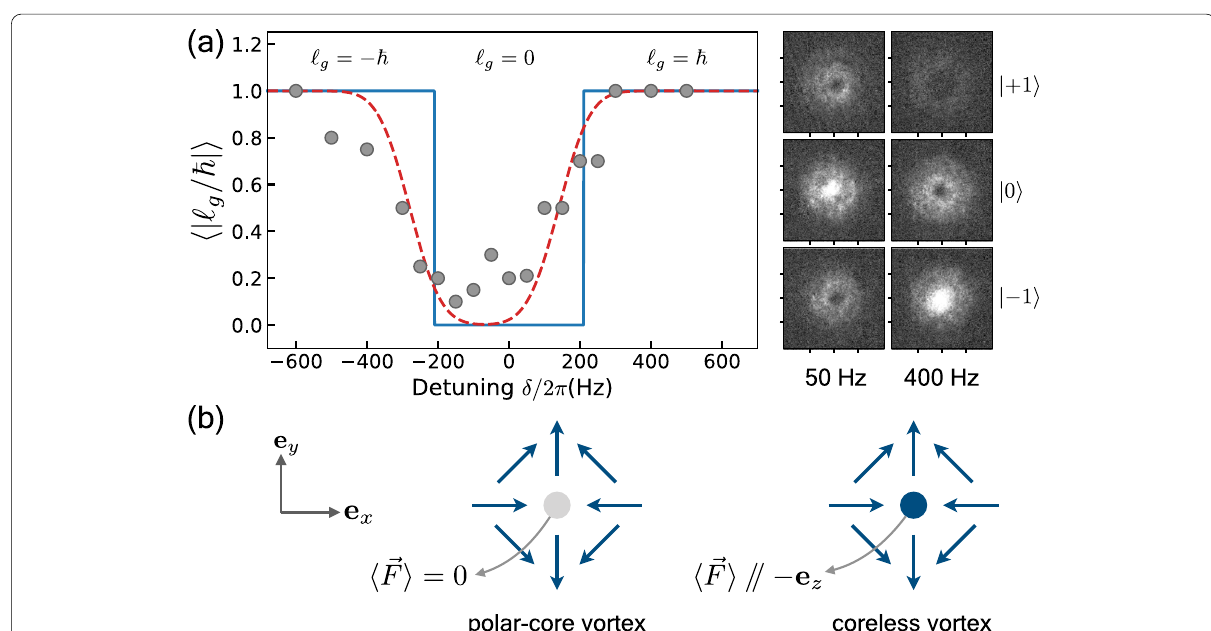
1 and l 0 states. The solid and dashed lines l g g = = (cid:31) (cid:31) (cid:31) (cid:31)